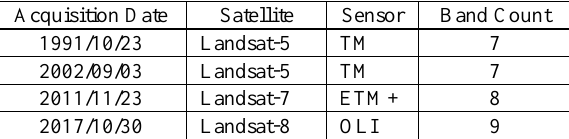
Table 1. Characteristics of data sources